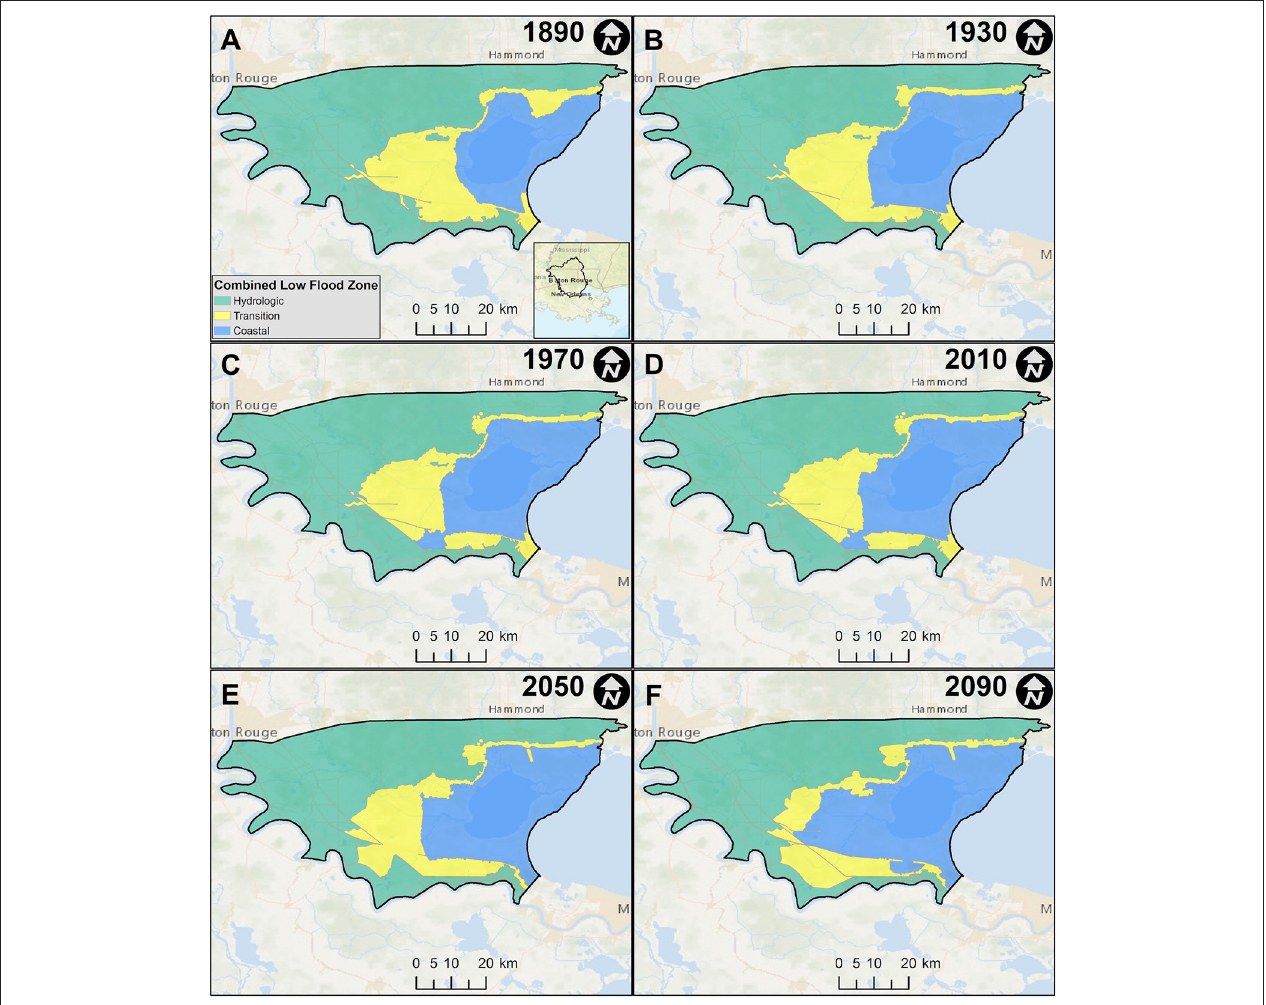
FIGURE 4 | Compound flood hazard zone delineation for the Lake Maurepas watershed using low flood events for (A) 1890, (B) 1930, (C) 1970, (D) 2010, (E) 2050, and (F) 2090. Service Layer Credits: Esri, Garmin, GEBCO, NOAA NGDC, OpenStreetMap, and the GIS User Community.